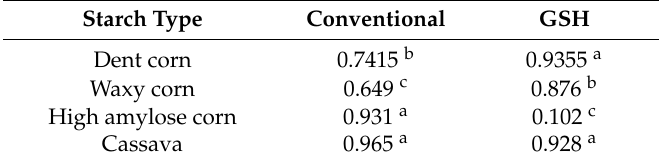
Table 2. Fermentation rates for ethanol production during the conventional and GSH process.